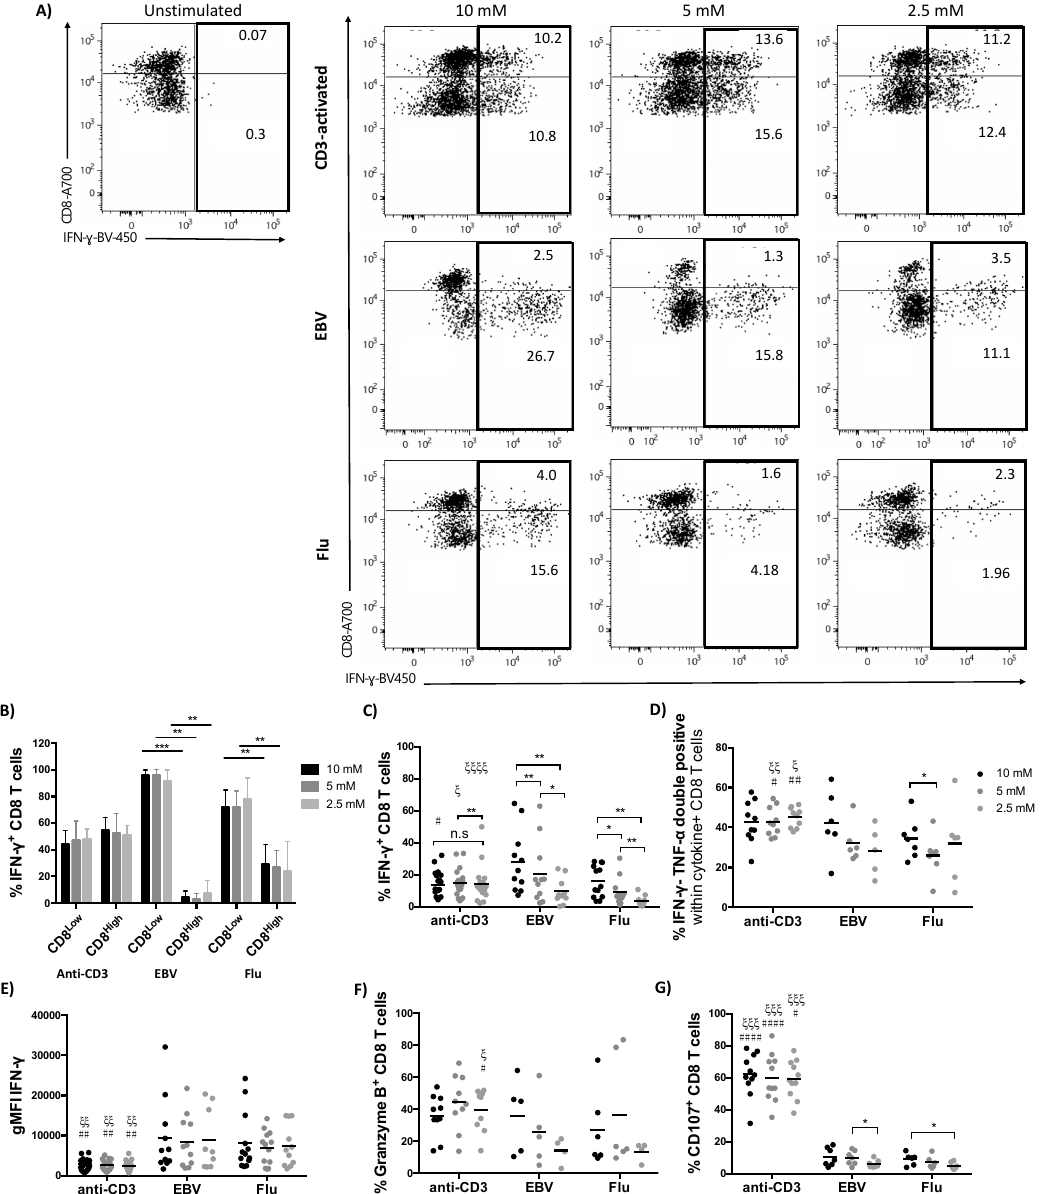
Figure 2. Glucose availability alters cytokine production by virus-specific but not CD3-activated CD8 T cells. T cells were stimulated as detailed in Figure 1A and cultured in the indicated glucose concentrations for the entire period of the experiment. Following overnight restimulation on day 7 cytokine production was determined. ( A ) Representative dot plots showing production of IFN- γ by CD3-activated or virus-specific CD8 T cells stimulated in di ff erent concentrations of glucose. ( B ) Distribution of IFN- γ + cells into CD8 low and CD8 high . ( C ) Percentage of CD8 + T cells producing IFN- γ and ( D ) percentage of CD8 T cells coproducing IFN- γ and TNF- α after respective stimulation. ( E ) IFN- γ geometrical mean fluorescence intensity (gMFI) in IFN- γ + CD8 + T cells. ( F ) Percentage of granzyme B + CD8 T cells and ( G ) percentage of CD107 + CD8 T cells after stimulation with anti-CD3, EBV and flu peptides in different concentrations of glucose. Mann–Whitney test was used when comparing between the same concentration of glucose in different groups, ξ p < 0.05, ξξ p < 0.01, ξξξ p < 0.001 when comparing with flu-stimulated group and # p < 0.05 ## p < 0.01 #### p < 0.0001 when comparing with EBV-stimulated group. Wilcoxon paired t test when comparing between glucose concentrations within the same group, * p < 0.05, ** p < 0.01, *** p < 0.001.